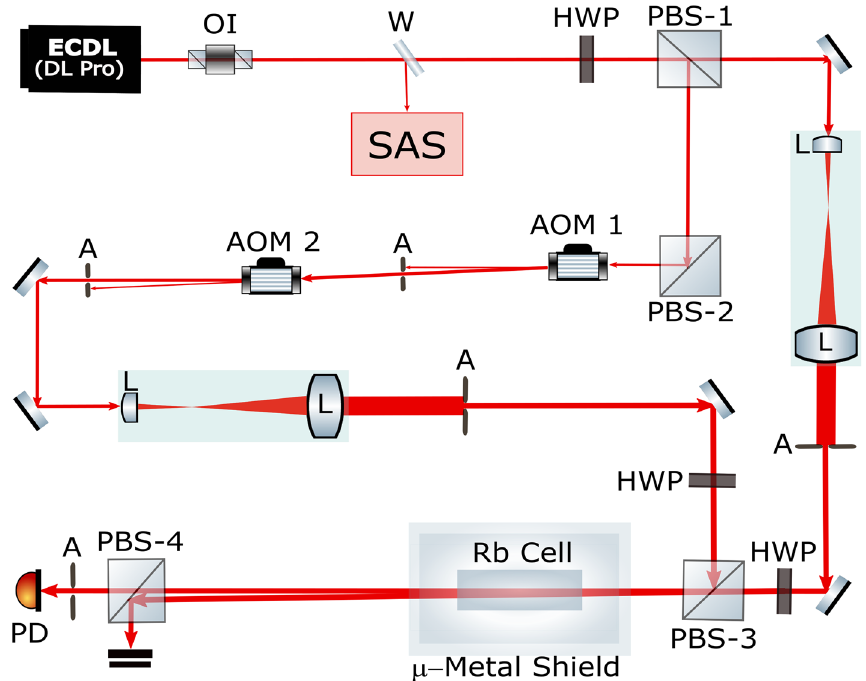
Figure 4. Experimental setup. Component symbols: OI: optical isolator; W: window; SAS: saturation absorption spectroscopy; HWP: half-wave plate; PBS: polarizing beam splitter; A: aperture; QWP: quarter-wave plate; L: lens; PD: photodiode; AOM: acousto-optic modulator. Figure 4 is drawn by the first author (Zeeshan Ali Safdar Jadoon) using free open-source scalable vector graphics editor Inkscape (Version: 1.0.2-2) available at: https:// inksc ape.